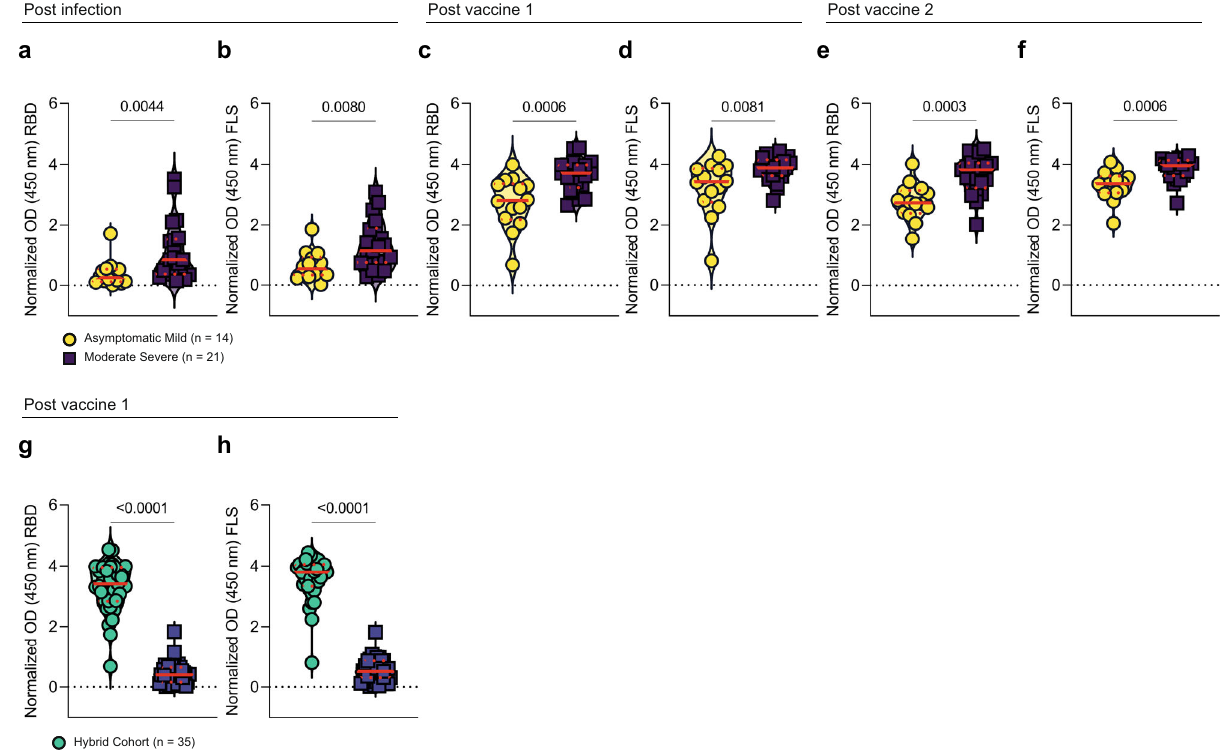
Fig. 2 Comparison of humoral responses against SARS-CoV-2 RBD and FLS between asymptomatic/mild, moderate/severe and control groups. Levels of a post infection (PI) anti-RBD and b PI anti-FLS IgG, c PV1 anti-RBD and d PV1 anti-FLS IgG and e PV2 anti-RBD and f PV2 anti- FLS IgG Ab levels were compared between asymptomatic/mild (yellow circle) and moderate/severe (purple square) groups. Levels of g anti- RBD and h anti-FLS IgG for all previously infected and matched COVID-19-naïve participants PV1 are compared. P values, shown above horizontal lines spanning comparison groups, were calculated using the Mann – Whitney U -test for ( a , c , d , f – h ), and unpaired Student ’ s t test for ( b , e ). Red lines bisecting groups represent median or mean (solid) with IQR or SD (dotted) as